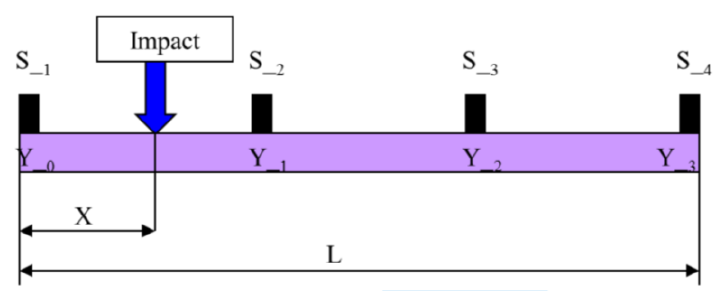
Figure 2. Mathematical modeling for an impact on a single bar with four piezoelectric sensors.